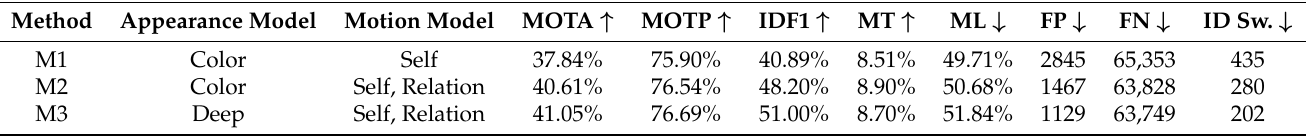
Table 3. Comparison with baseline MOT algorithm and MOT with our proposed global